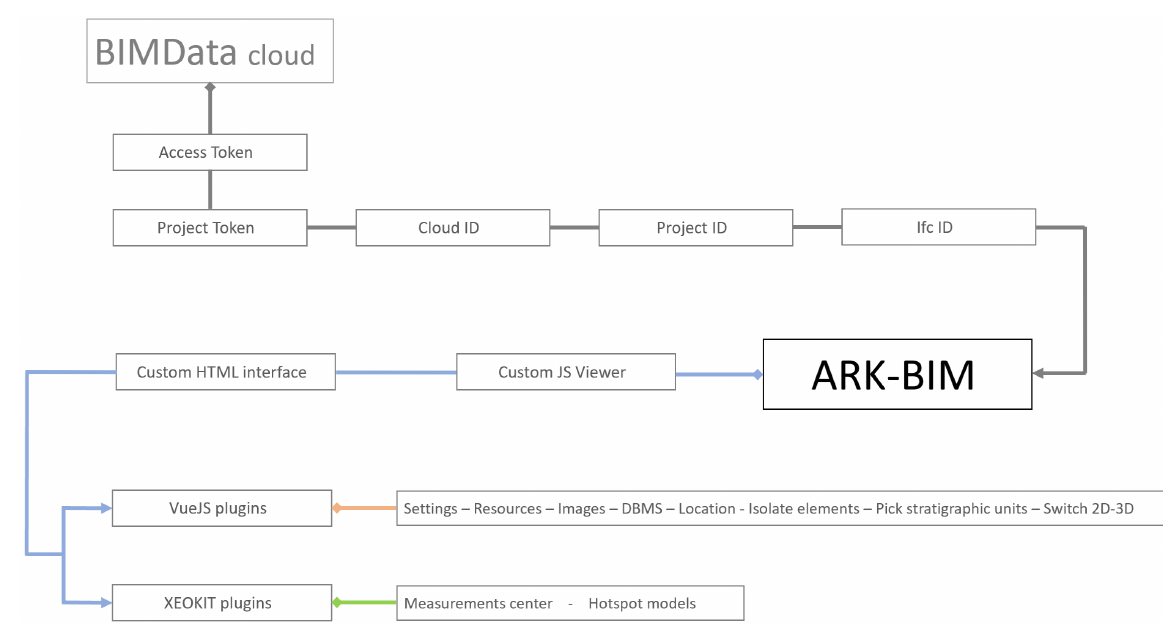
Figure 3. ARK-BIM main framework idea: from the BIMData cloud to the custom platform through security tokens, including ad-hoc plugin developments in a custom viewer.